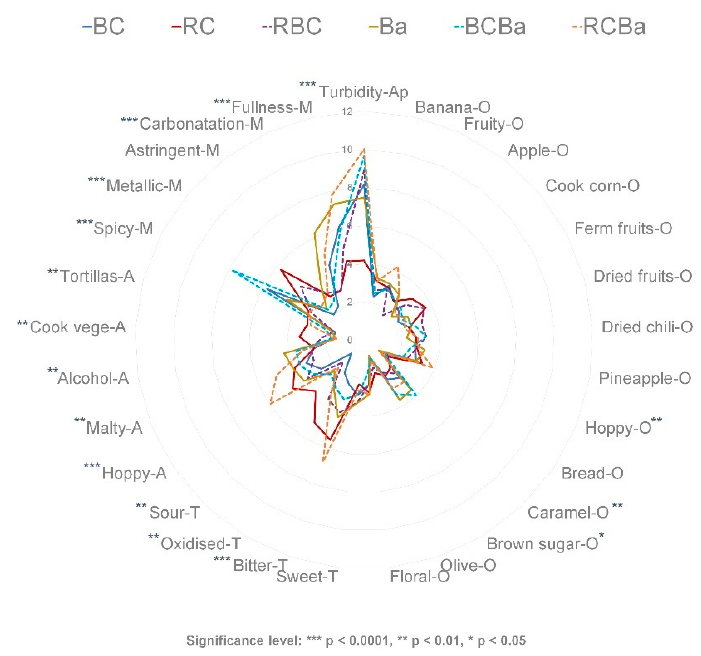
Figure 1. Sensory profile of the six beers. BC = 100% blue corn, RC = 100% red corn, RBC = 50:50 red and blue corn, Ba = 100% barley, BCBa = 50:50 blue corn and barley, RCBa = 50:50 red corn and barley.